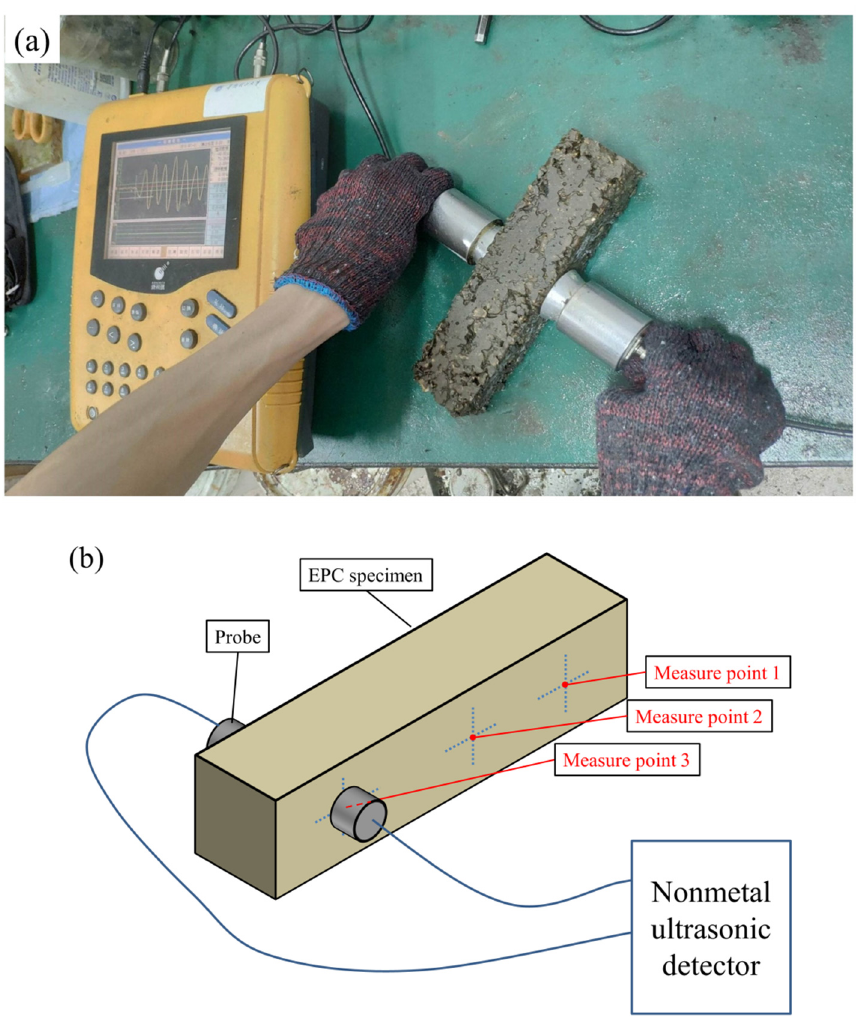
Figure 4. ( a ) The detection of ultrasonic wave velocity propagating through EPC; ( b ) Schematic diagram of the detection.